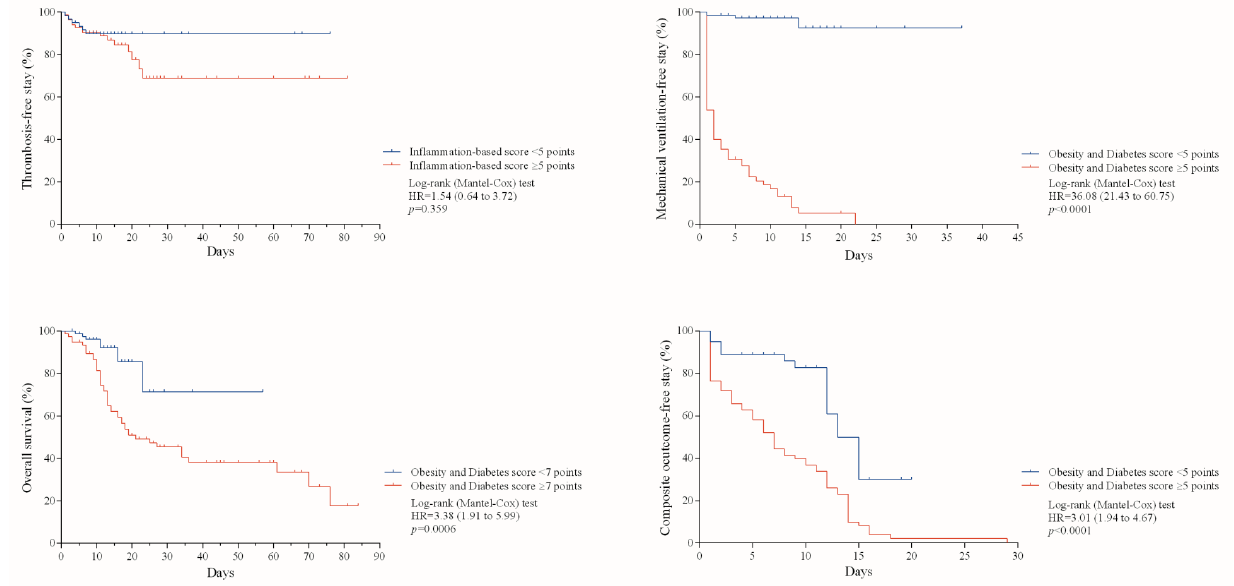
Figure 2. Cumulative survival curves for the occurrence of major adverse outcomes during hospital stay.